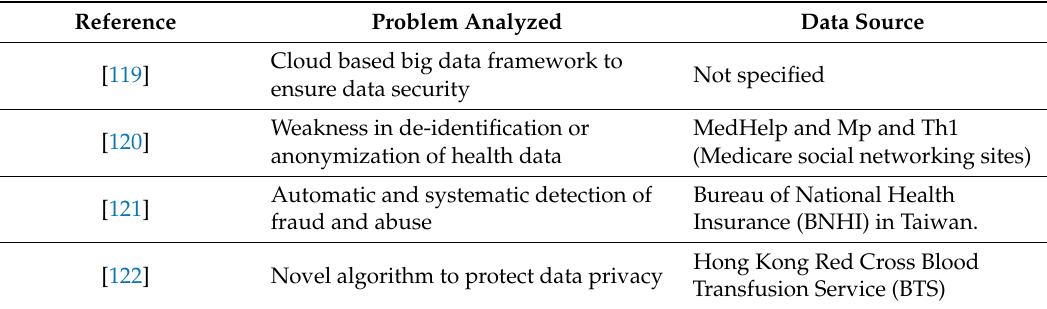
Table 7. List of papers in healthcare privacy and fraud